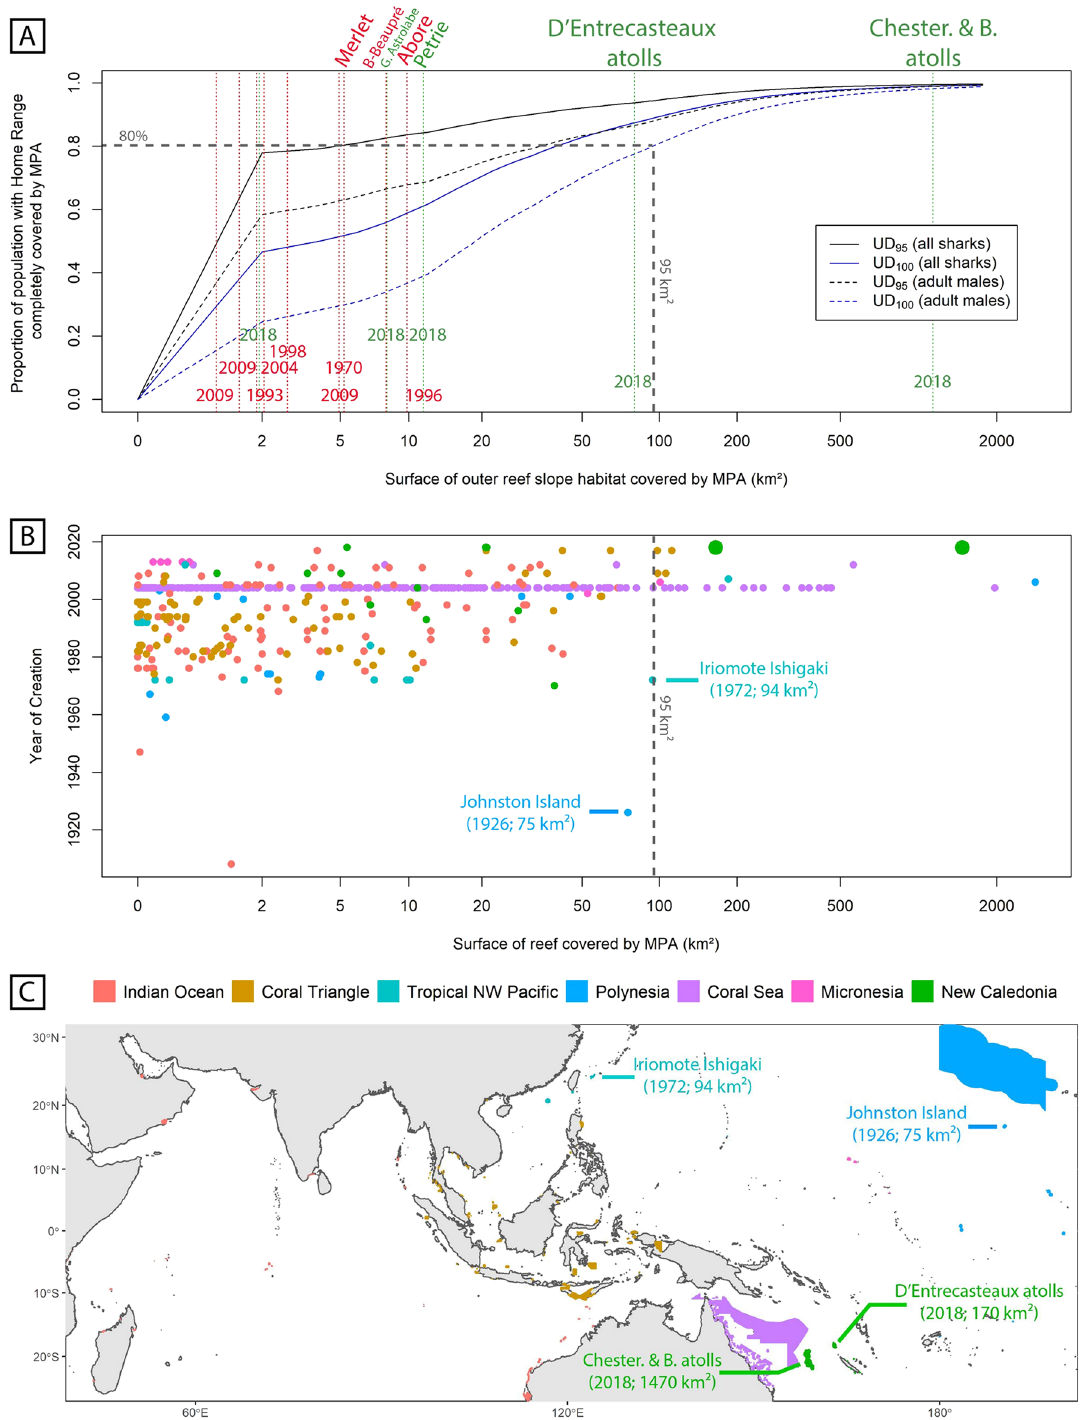
Figure 3. Marine Protected Areas (MPAs) ability to protect grey reef shark home range according to their size. ( A ) Distribution of home range values were used to model the ability of an MPA covering a given area of outer reef slope to cover sharks home range. This ability was modelled considering all sharks (plain lines) or adult males only (dotted lines). Black and blue lines present the ability of MPAs to cover sharks’ UD 95 and UD 100 respectively. New Caledonian MPA sizes are displayed with vertical dashed lines, in red for old MPAs (before 2010) and in green for recent ones. ( B ) Indo-Pacific MPAs from the World Database of Protected Areas (UNEP- WCMC, 2014) classified according to creation year and covered area of reef. ( C ) Location of Indo-Pacific MPAs. Graphics generated with R package ggplot2 (https:// ggplo t2. tidyv erse. org) and rgdal (https:// CRAN.R- proje ct. org/ packa ge=